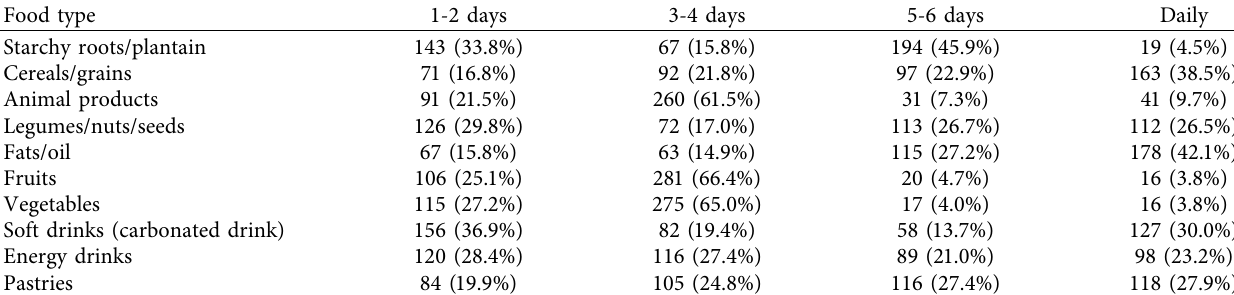
Figure 3: Eating habits of meals in a day. BF: breakfast; BFT: breakfast time; BFS: snack after breakfast; LH: lunch; LHT: lunchtime; LHS: snack after lunch; SUP: supper; SUPT: supper time; and SUPS: snack after supper. Table 2: Consumption of various food groups and